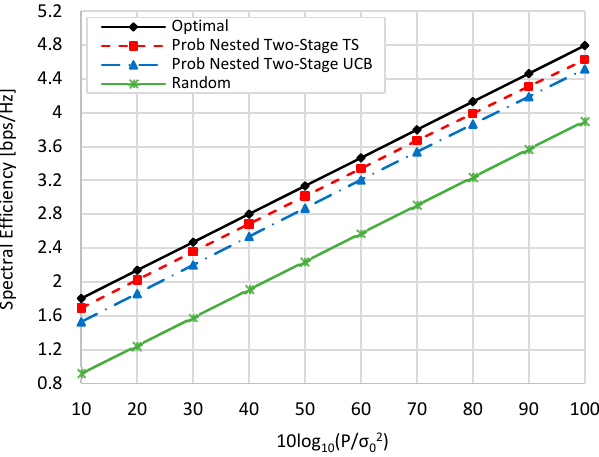
Figure 6. Spectral efficiency against TX SNR when M = N = K = 16 at zero blockage.